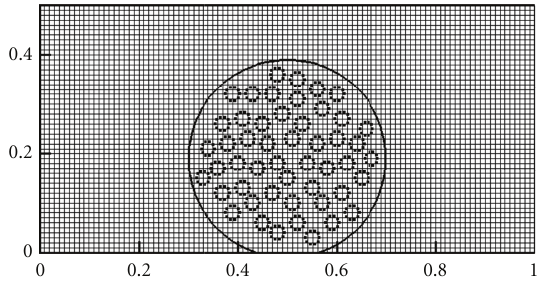
Figure 4: An example finite-element mesh with the initial drop interface. Particles, denoted as collocation points along the particle boundary, are distributed randomly inside the